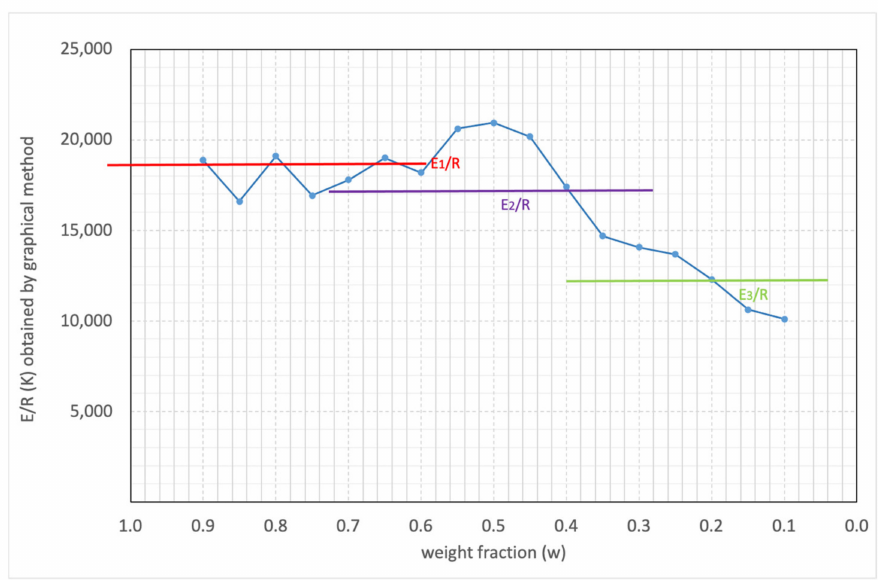
Figure 10. Activation energy (E/ R ) calculated using the py-isoconversional method linearizing differential equation. The E/ R values obtained by numerical integration and optimisation were plotted for comparison